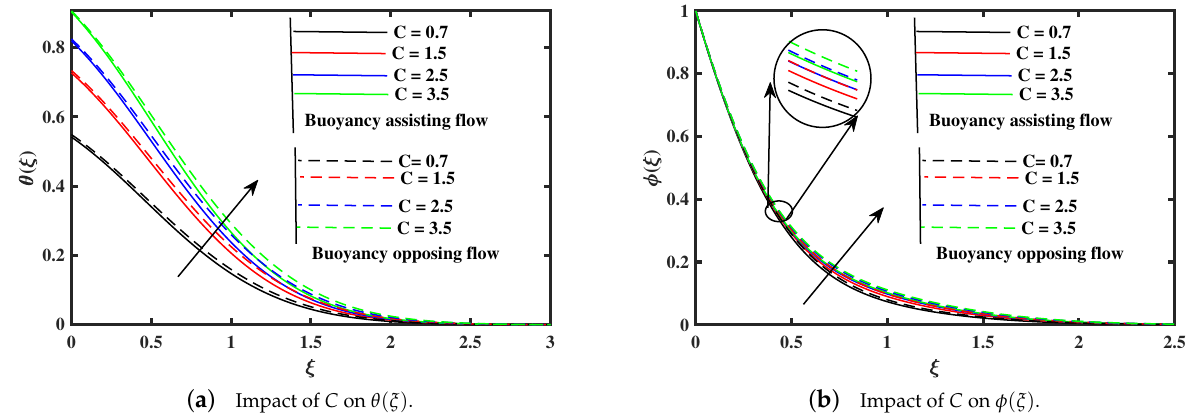
Figure 10. Fluctuation of θ ( ξ ) and φ ( ξ ) against Biot number ( C